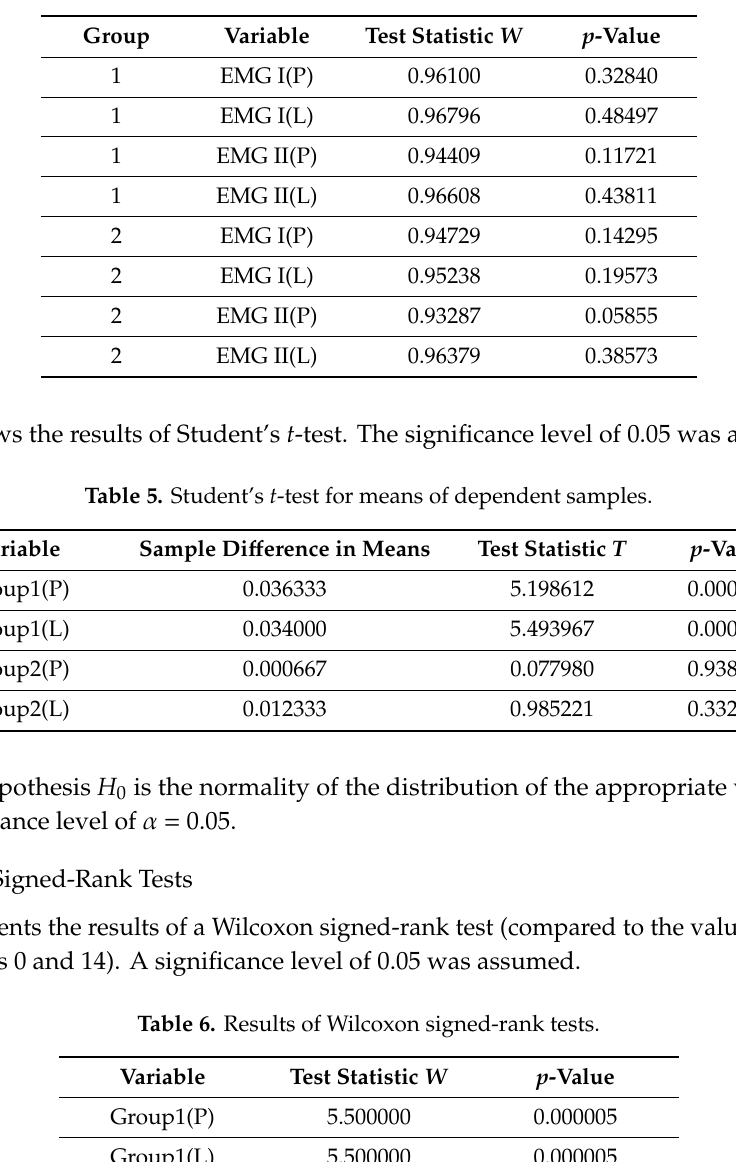
Table 4. Normality tests of all variables.